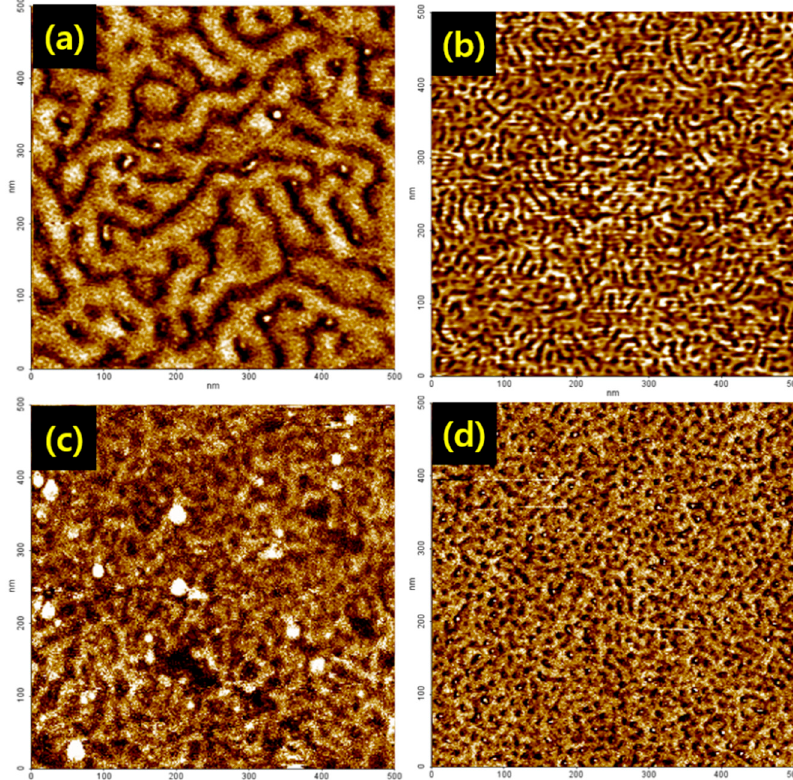
Figure 4. The AFM phase images of the modified membranes. ( a ) SEBS, ( b ) SEBS-g-MA, ( c ) S-SEBS, ( d ) S-SEBS-g-MA.